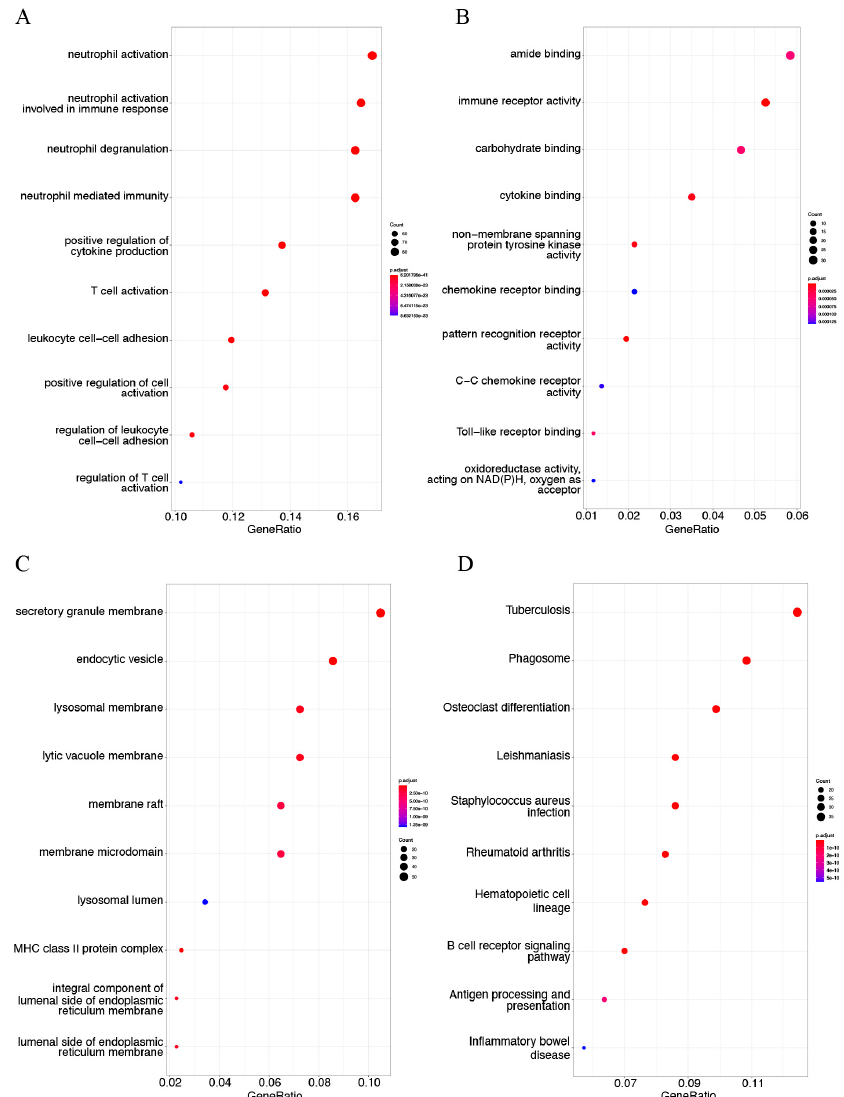
Figure 5. Gene Ontology (GO) term annotation and Kyoto Encyclopedia of Genes and Genomes (KEGG) pathway analysis of upregulated DEGs in AS in GSE100927. Detailed information relating to changes in the ( A ) biological processes (BP), ( B ) molecular functions (MF), and ( C ) cellular compo- nents (CC) of upregulated DEGs between control samples and atherosclerotic tissues through GO enrichment analysis. ( D ) The KEGG pathway analysis of upregulated